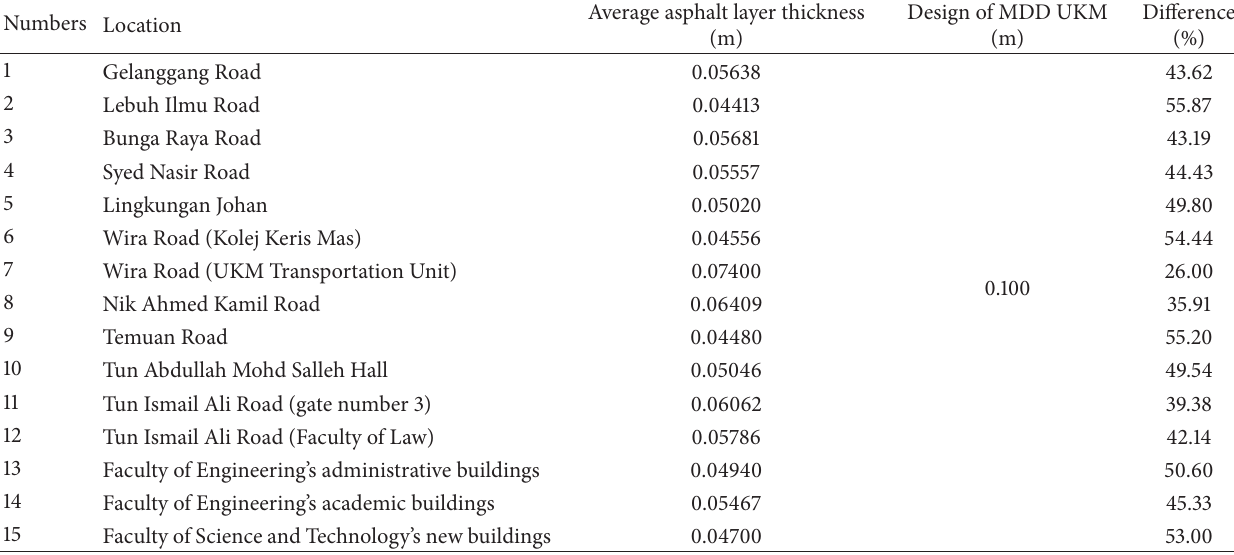
Table 3: A comparison between the average asphalt layer thickness and the design proposed by MDD